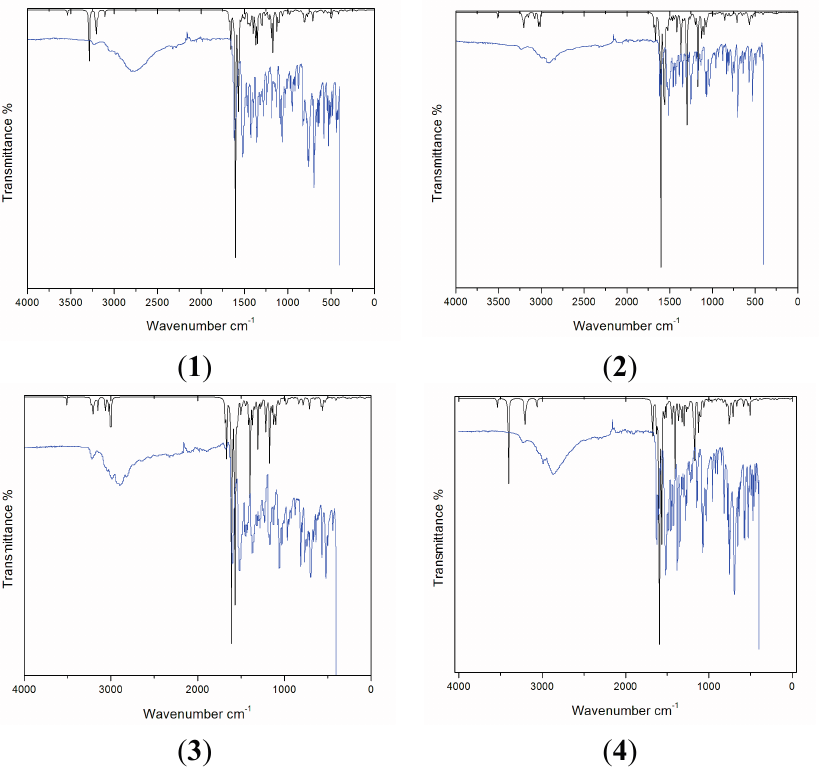
Figure 5. Simulated (balck) and experimental (blue) vibrational spectra of compounds 1 – 4